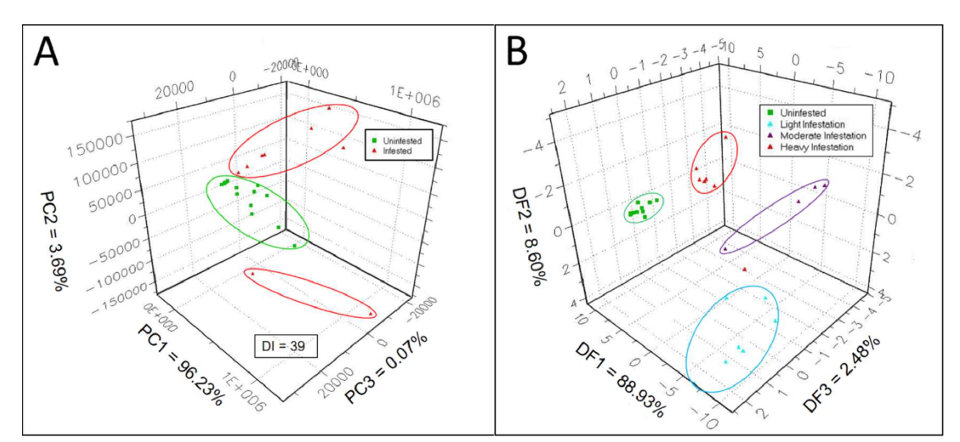
Figure 1. Discrimination between VOC-metabolite profiles of green ash sapwood cores with different levels of EAB infestation. Three-dimensional factor analysis of e-nose aroma classes by: ( A ) Principal component analysis (PCA) between uninfested (healthy) sapwood and EAB-infested sapwood; ( B ) discriminant factor analysis (DFA) between sapwood cores from different tree crown health classes corresponding to various levels of EAB sapwood infestation. The Discrimination Index (DI) value for 3-d PCA was statistically valid at P < 0.05 level of significance.